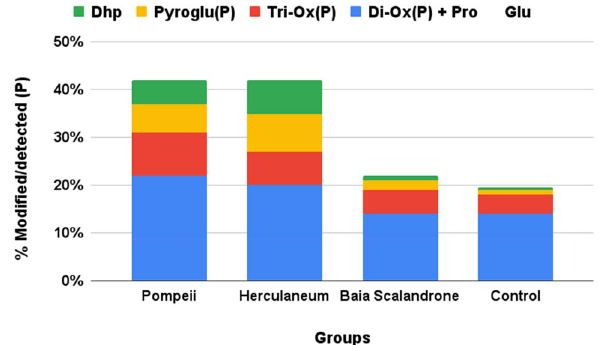
Figure 8. Extent of modified proline residues, reported as percentage of modified over detected (modified plus unmodified)